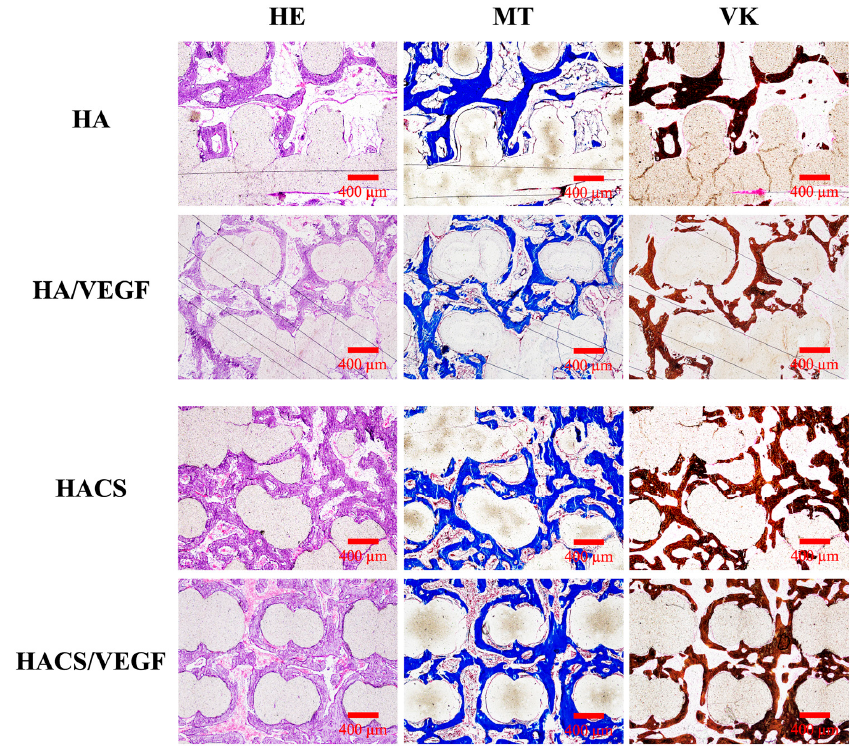
Figure 10. Histological analysis of new bone regeneration around and within the scaffolds in the rabbit femoral defect model. Left: hematoxylin and eosin (HE) stain; middle: Masson’s trichrome (MT) stain; right: von Kossa (VK) stain of regenerated bone mass after 8 weeks of regeneration for in vivo experiment.